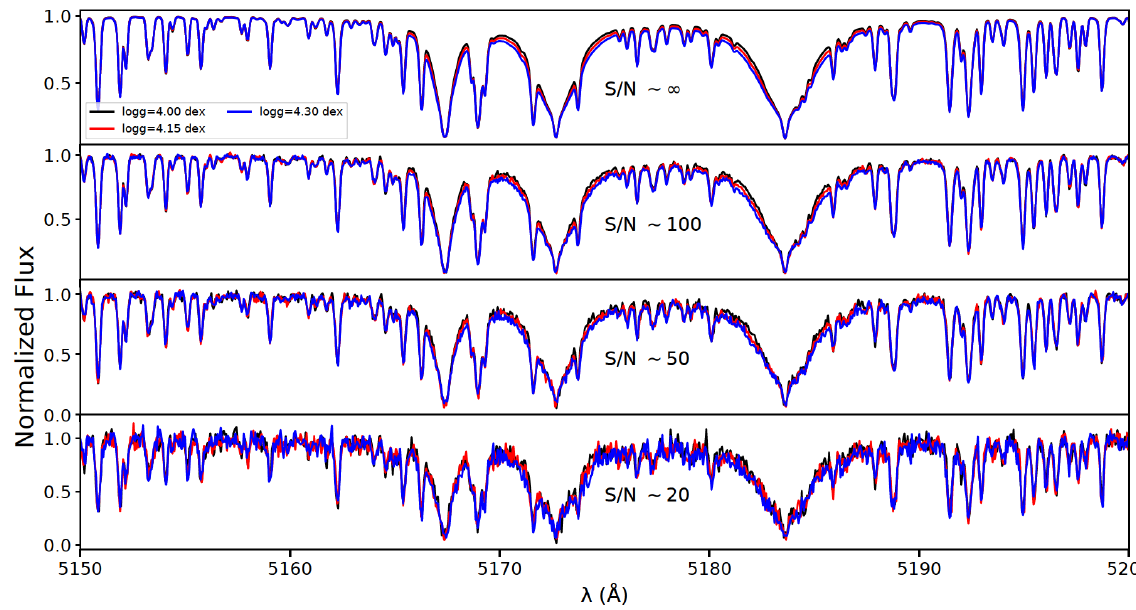
Figure 6. Synthetic spectra of G stars having [ T eff ,log g ,[ M / H ], v sin i ] of 5200 K,[4.00,4.15,4.30 dex], 0.0 dex, 6 kms −1 . Each plot displays the spectra with different S/N.